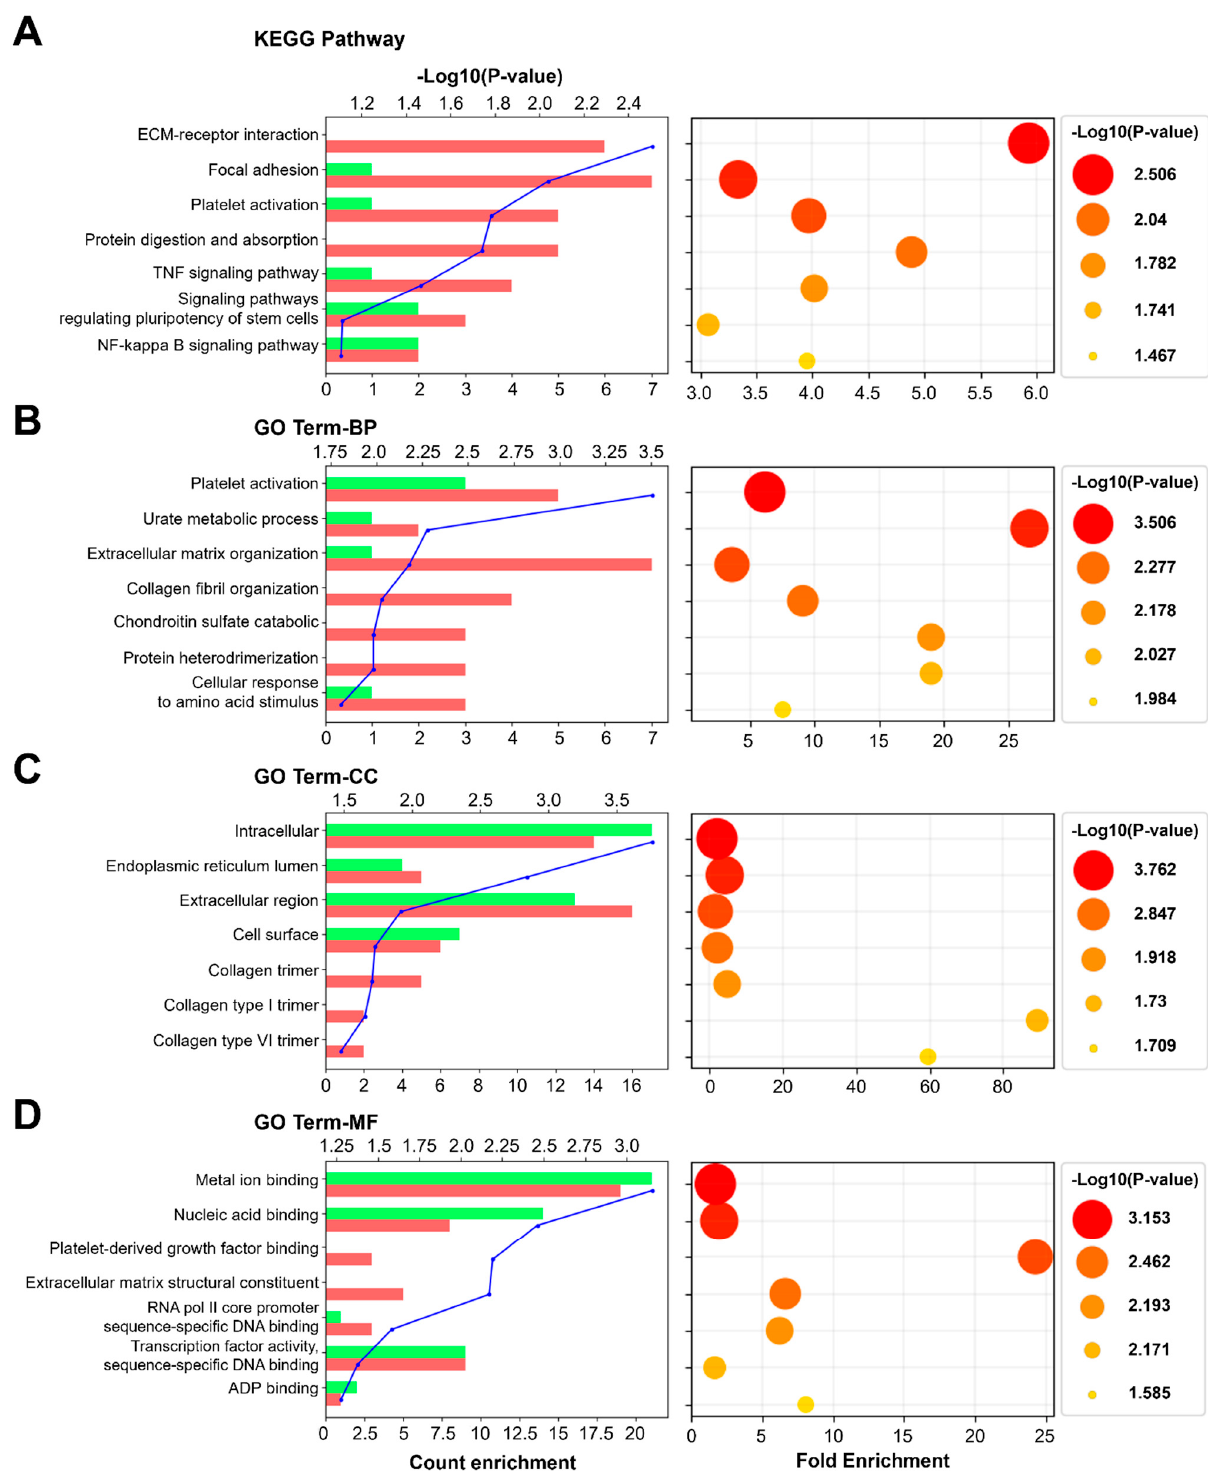
Figure 6. GO term and functional enrichment analyses of the biomarkers of sodium cyanide exposure. The top 7 most significantly affected pathways or GO terms are listed along the y-axes. The x-axes indicate count enrichment and fold enrichment. The pathways or terms with p -value < 0.05 were considered significantly enriched. The color and size of each dot indicate − Log 10 ( p -value). ( A ) KEGG pathway. ( B ) Biological process. ( C ) Cellular component. ( D ) Molecular function. GO, gene ontology.